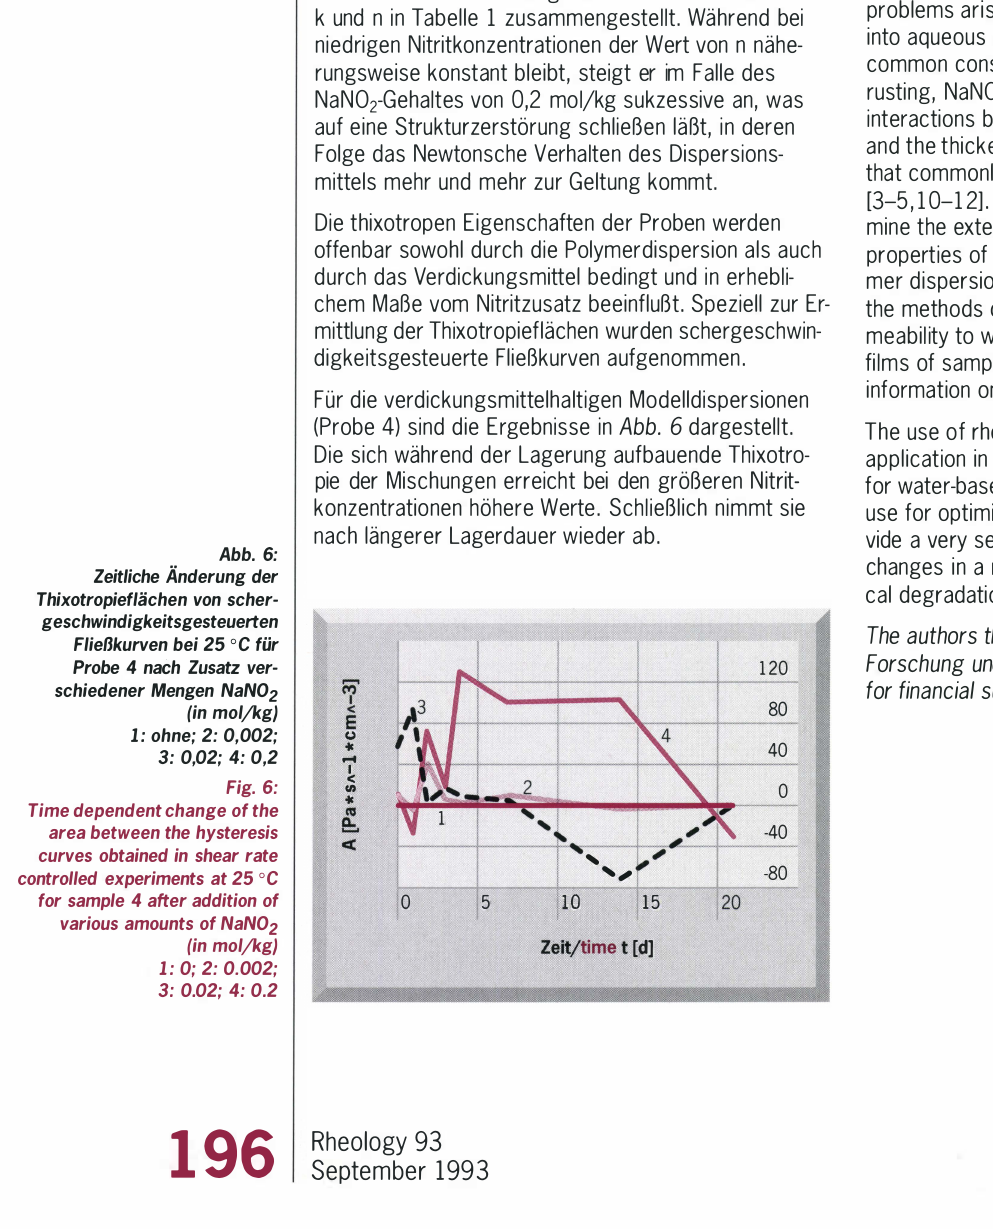
Fig. 5: Time dependent change of the limiting viscosity at zero shear rate 11 0 = 11 (D __, 0) at 25 o c for samples 1-4 after addition of NaNOz (0.02 mol/kg)